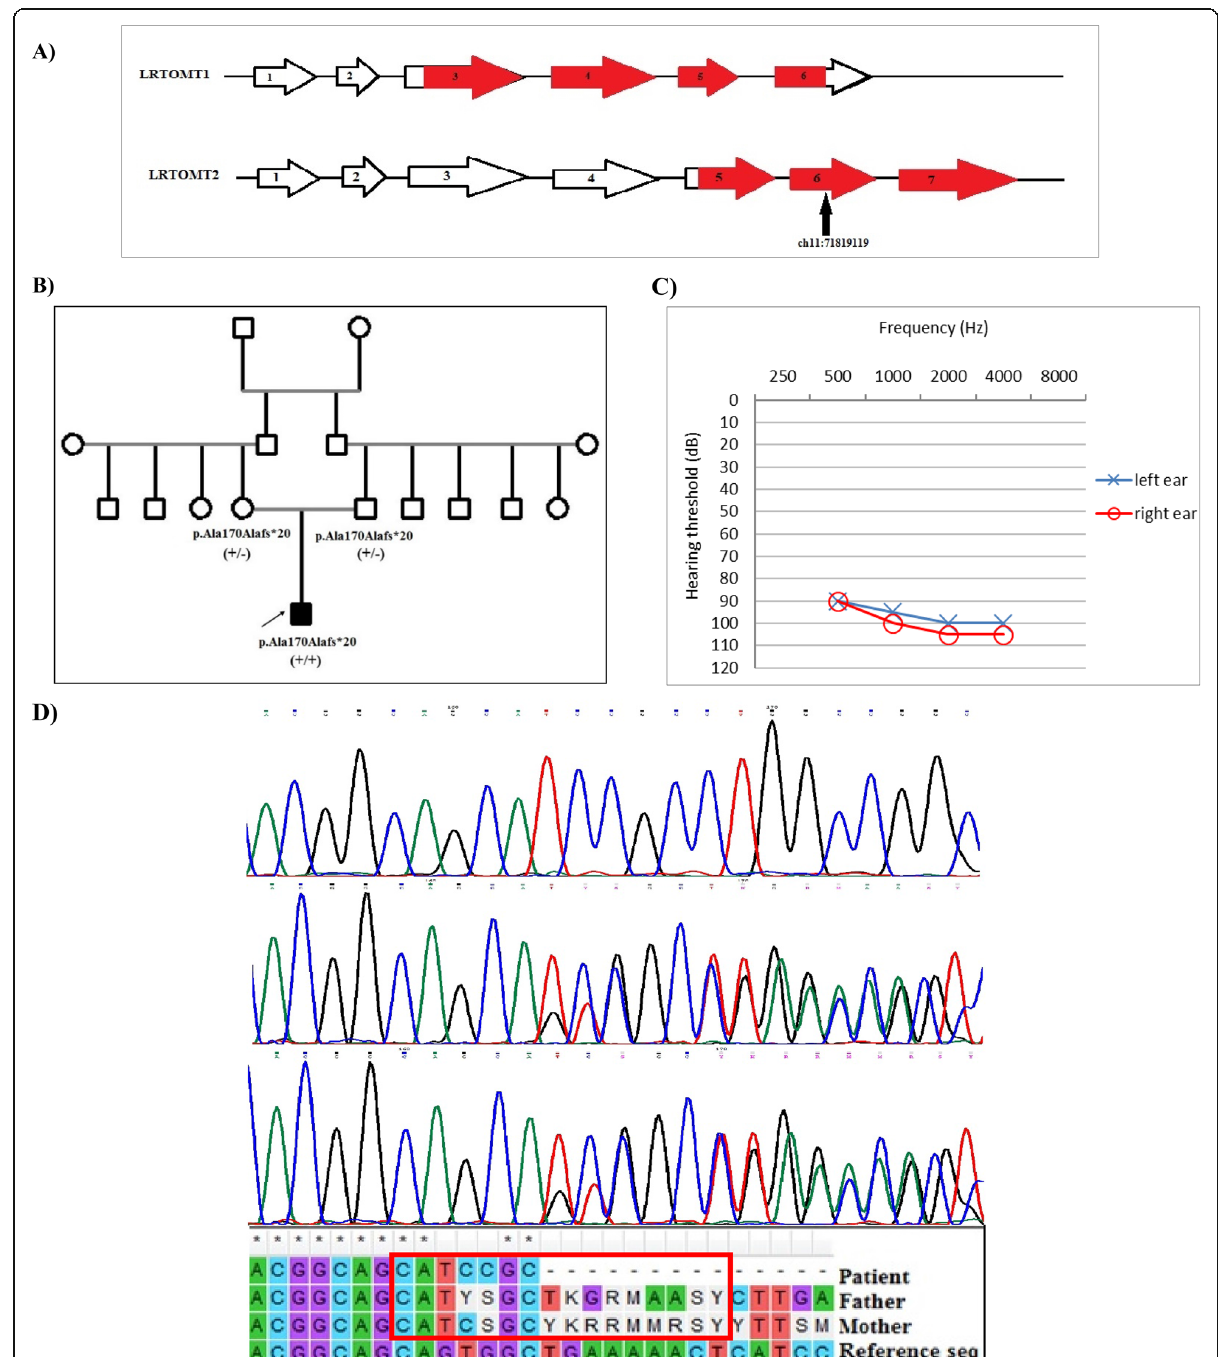
Fig. 1 a Two isoforms encoded by the LRTOMT gene: LRTOMT1 and LRTOMT2. LRTOMT1 starts in exon 3 and LRTOMT2 starts in exon 5. CDS regions are colored red. In this transcript of LRTOMT (NM_001145308), LRTOMT2, starts from exon 3 and ends in exon 7. b Pedigree of the family. The proband is marked by an arrow. c Pure tone audiogram of patient. Audiogram indicate sever-to-profound hearing loss in both ears. Frequency in hertz (Hz) and the hearing threshold in decibels (dB) are shown. d The electropherogram of the muatation in the patient (A1), deletion of 16 bp homozygously, in his father (A2) and his mother (A3) heterozygously. In the bottom of the electropherograms, the comparison of three sequence with refrence sequence is shown. The deleted 16 bp is shown in red